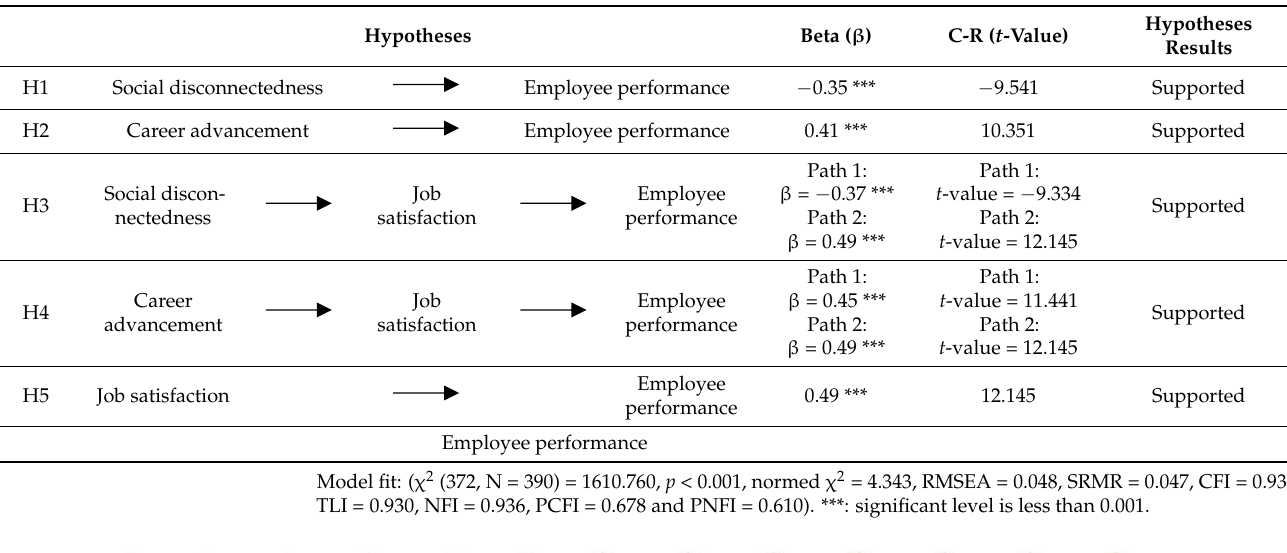
Table 4. The structural model results.